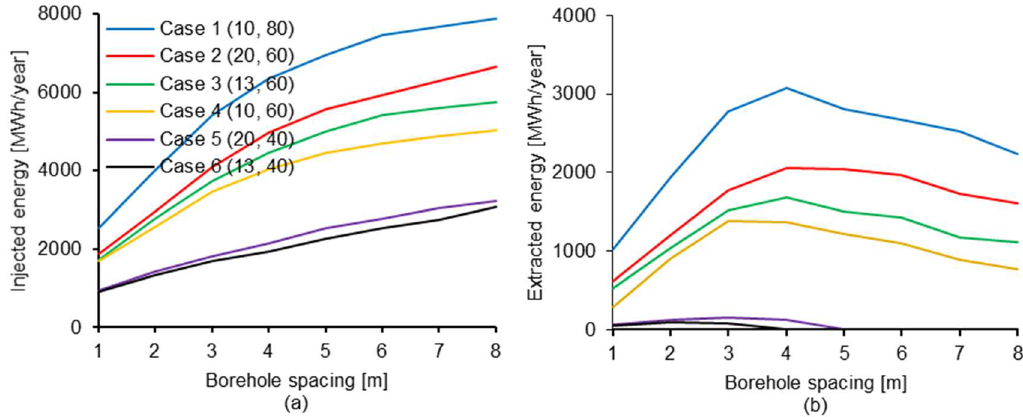
Figure 12. Annual injected ( a ) and extracted ( b ) energy as a function of borehole spacing. Values given in legend parentheses are the mass flow rate and temperature of the supply flow at heat injection respectively. 4 m is the actual borehole spacing.